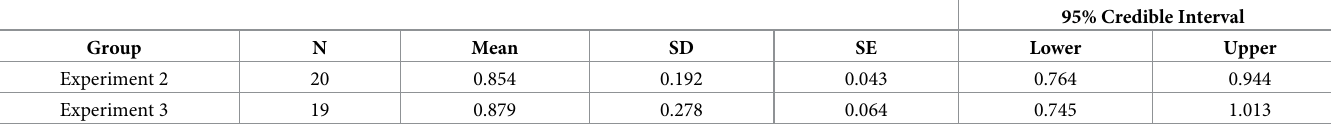
Table 3. Descriptive statistics. Descriptives of the comparison of mean spatial error in HV groups of Experiment 2 and 3, by means of a Bayesian independent